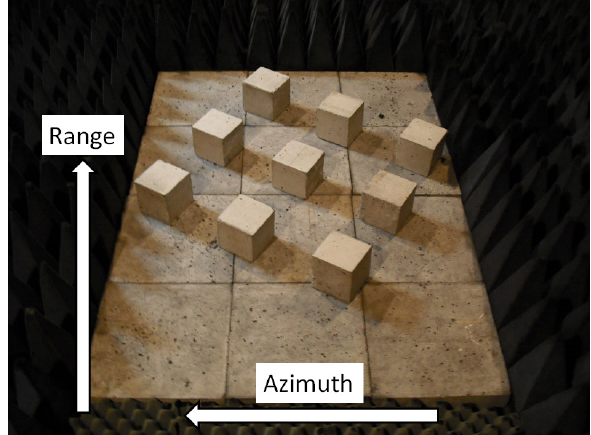
Figure 3. Measurement of scattering of blocks. The distance between the blocks and the orientation angle were 15 cm and 30 ◦ respectively.